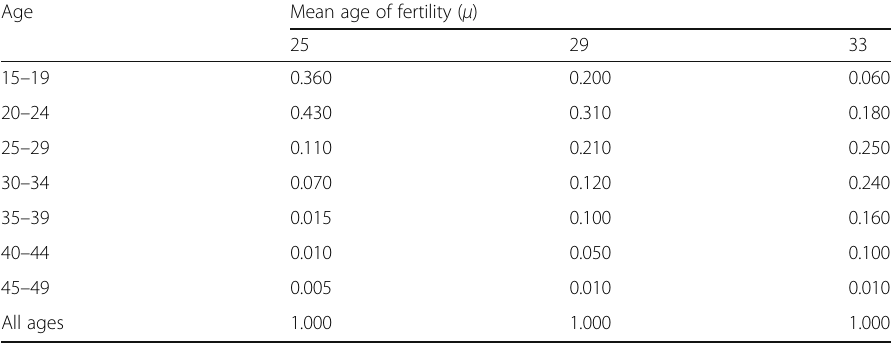
Table 4 Age-specific fertility values ( f j ) for three mean ages of fertility ( μ ) Age Mean age of fertility ( μ